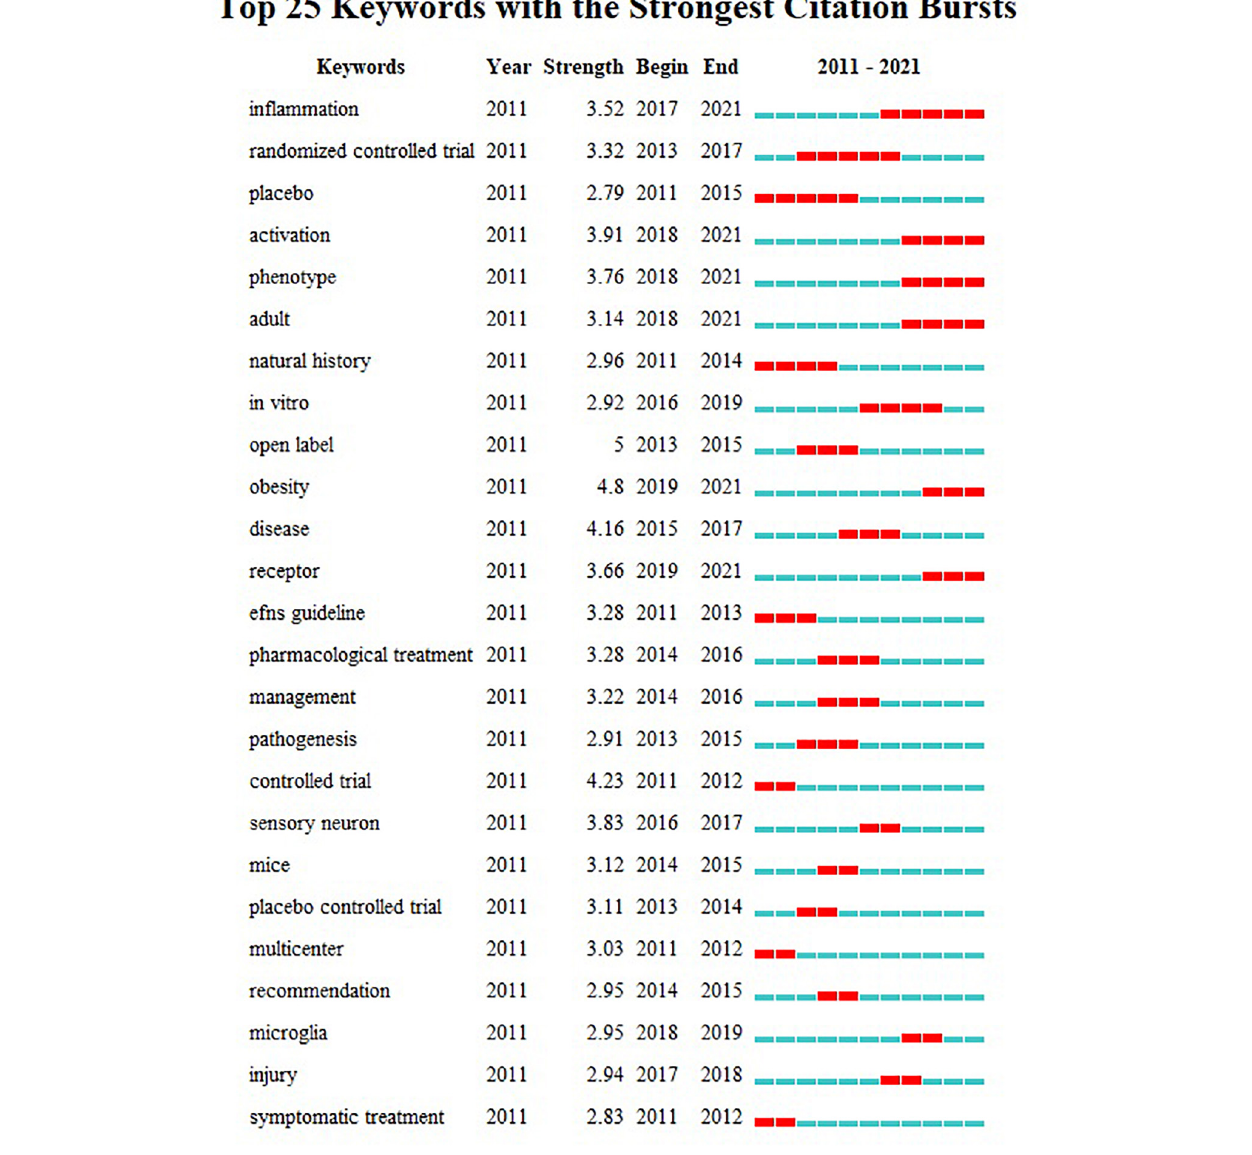
FIGURE 11 | The keywords with the strongest citation bursts of publications on DPNP